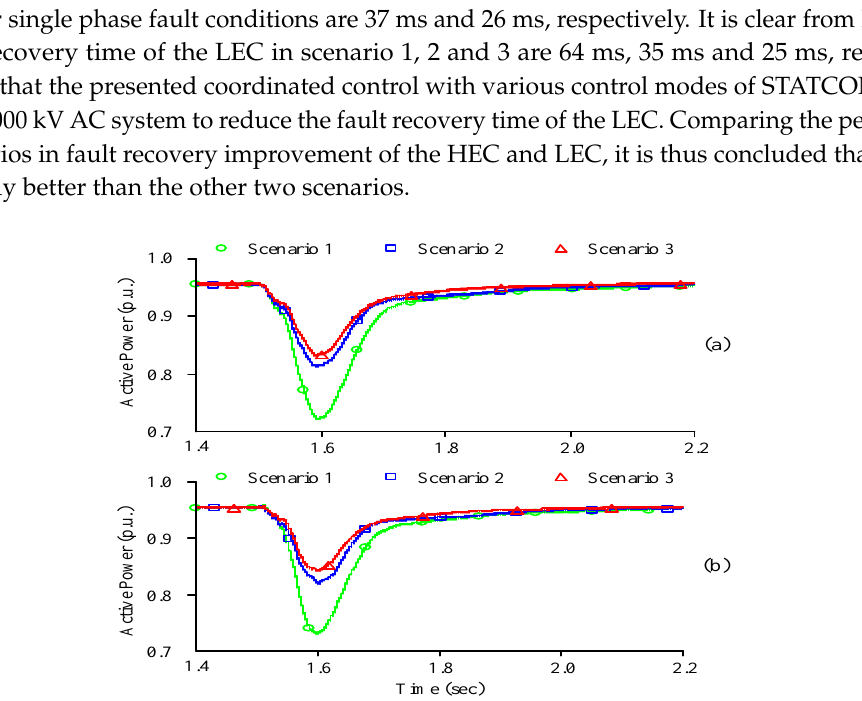
Figure 10 . Active power of the UHVDC-HCS system with and without coordinated control Figure 10. Active power of the UHVDC-HCS system with and without coordinated control under under single phase fault conditions: (a) HEC; (b) LEC single phase fault conditions: ( a ) HEC; ( b )